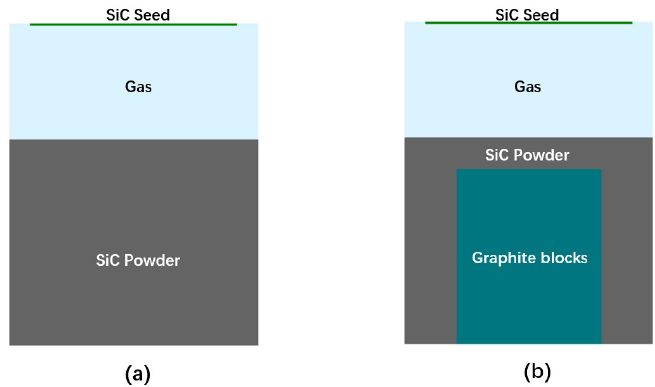
Figure 2. Different structures inside the graphite crucible: ( a ) traditional structure. ( b ) optimized